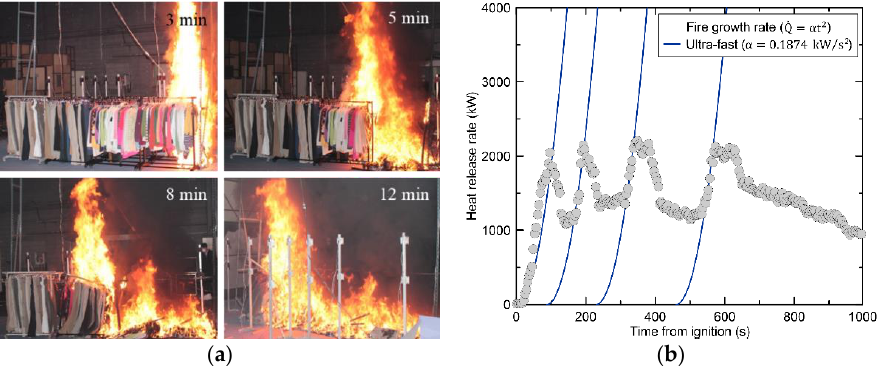
Figure 5. Fire spread pattern and heat release rate of clothing hanging on hangers: ( a ) Sequential photographs of fire spread over time; ( b ) measured heat release rate.